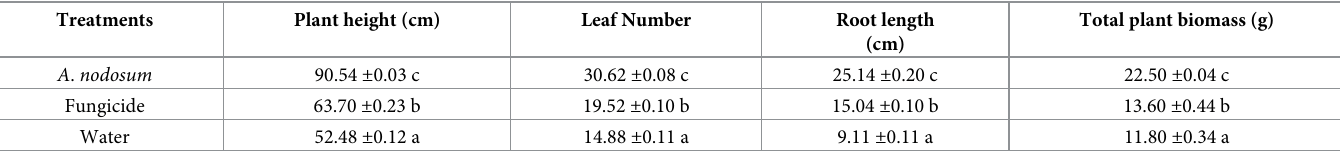
Table 3. Effect of A . nodosum extract application on plant growth parameters in sweet pepper. Treatments